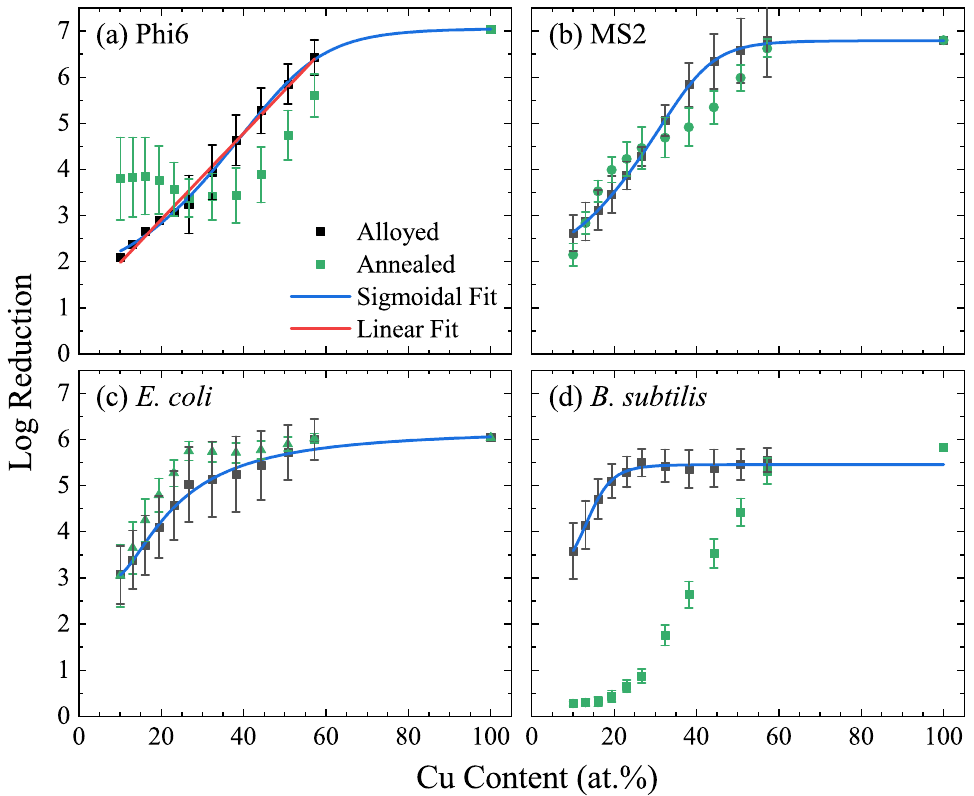
Figure 6. Line-cuts of the antimicrobial activity for ( a ) Phi6, ( b ) MS2, ( c ) E. coli , and ( d ) B. subtilis , taken across the equatorial ray of the wafers between Cu and